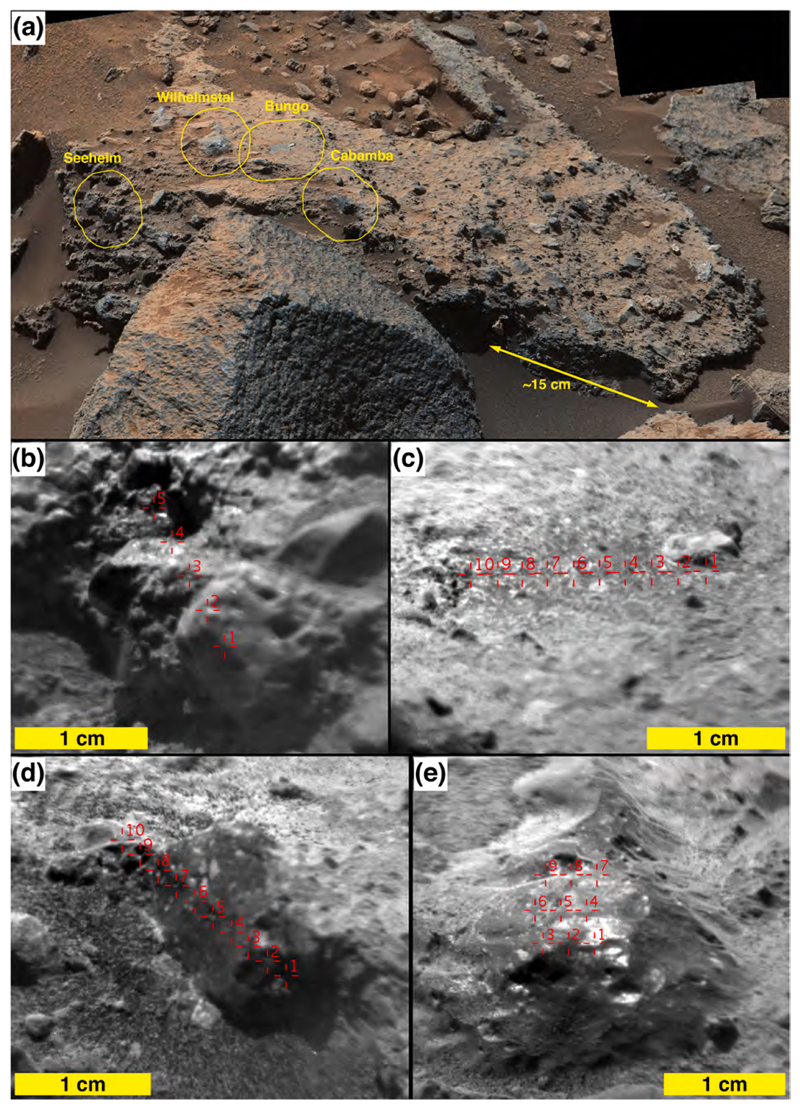
(a) Conglomeratic boulder investigated via four ChemCam targets. (b–e) Respective RMI views and LIBS target areas of Seeheim, Bungo, Cabamba, and Wilhelmstal. Note the vitreous luster of Wilhelmstal, and similarity to Cabamba.